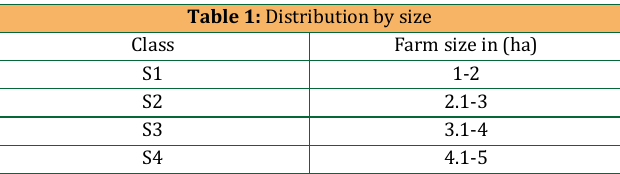
Table 1: Distribution by size